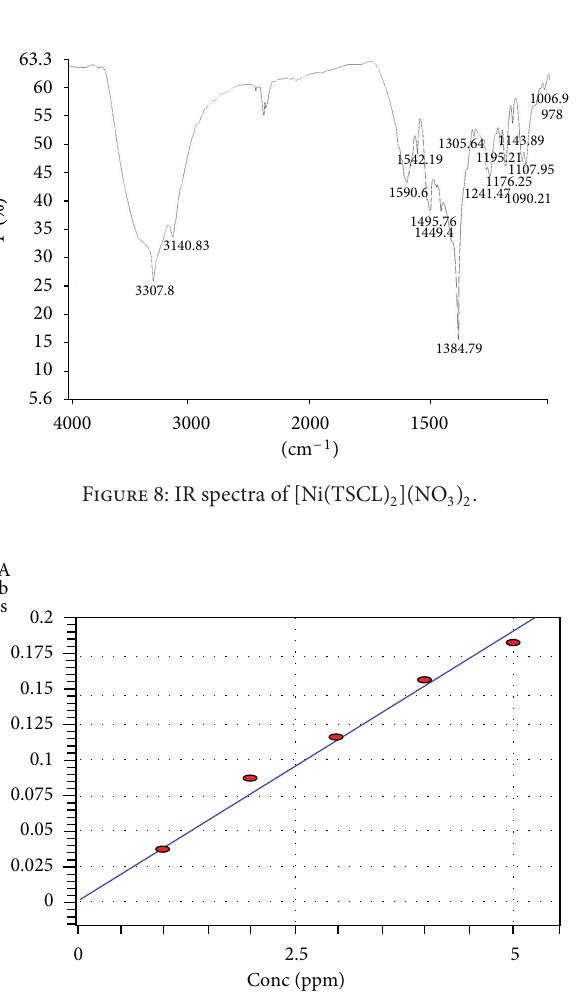
F 7: IR spectra of [Co(TSCL)